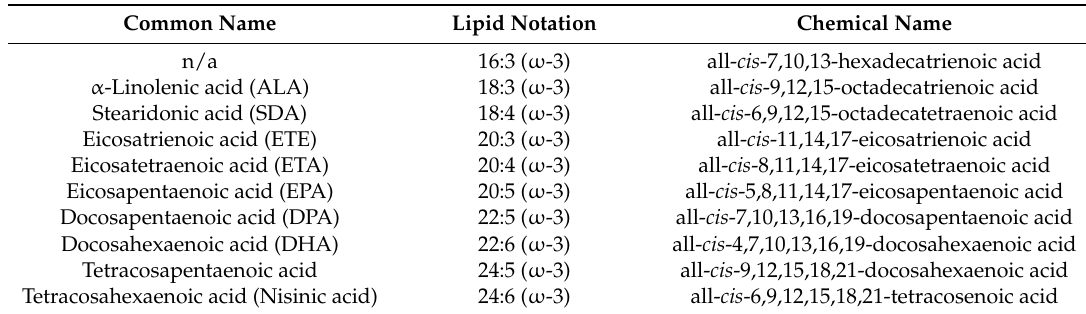
Table 2. Common ω -3 fatty acids found in